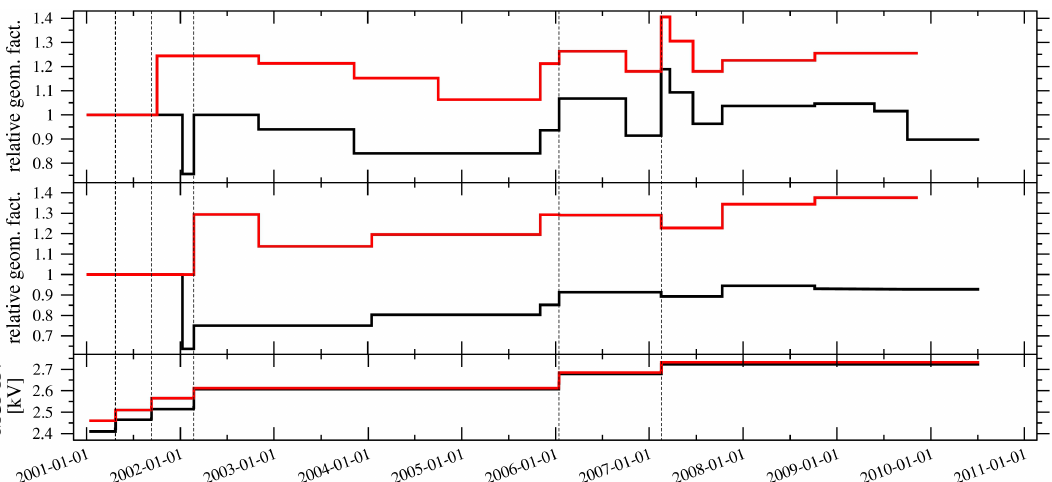
Fig. 8. Evolution of the HIA HS and LS efficiency (top and middle panels, respectively), and of the high voltage applied to the MCPs (bottom panel). Black lines refer to C1 and red lines to C3. The time axis spans from 1 January 2001 (around the start of Cluster’s operational phase) to the beginning of 2011. The dates of MCP HV increase are also shown by vertical dashed lines.